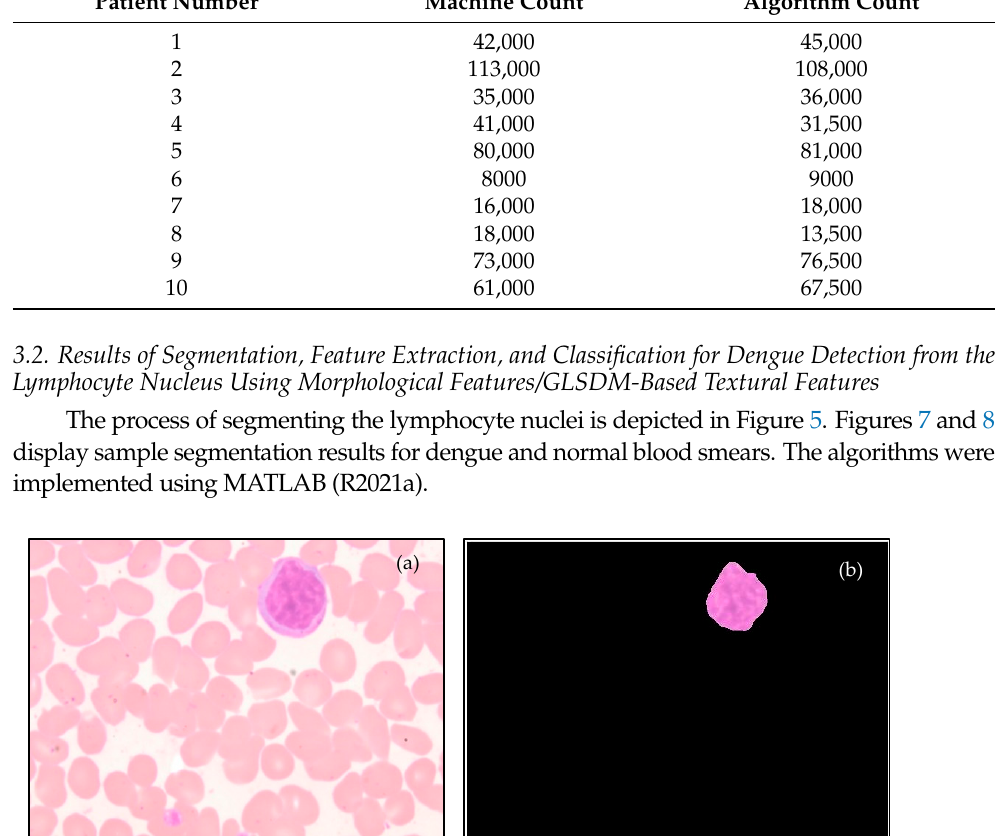
Table 2. Platelet counts per microliter of blood.